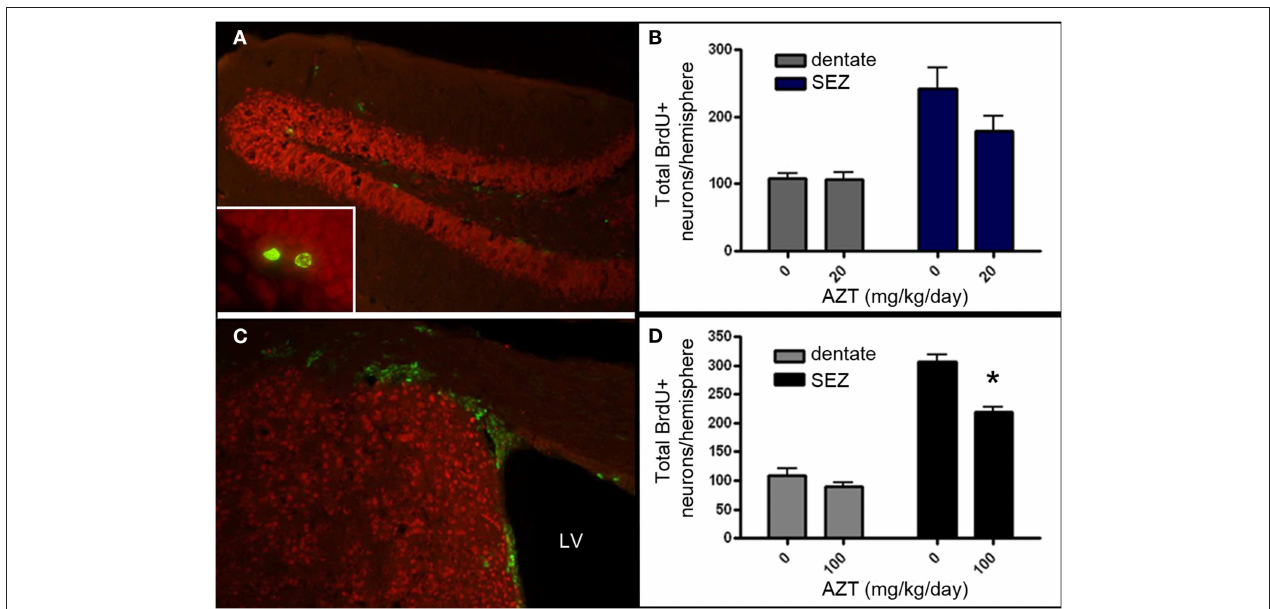
layer of the dentate gyrus, immediately superficial to the subgranular zone.Neither the 20mg/kg/day (B) nor the 100mg/kg/day (D) regimen significantly altered the number of newly-generated cells (green) in the dentate gyrus (gray bars in both B,D ). However, both regimens reduced proliferation in the SEZ (blue bars in B , black bars in D ), though only the 100mg/kg AZT dose reached statistical significance. Unpaired Student’s t -test. NS, no significant difference. Asterisk indicates significant difference, p < 0 . 01 . N = 4 for all groups. Error bars represent standard